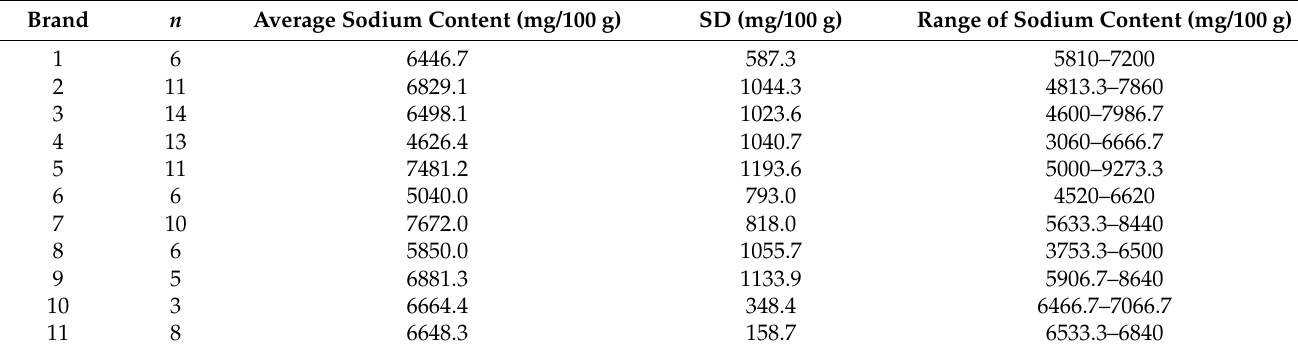
Table 3. The sodium content in 11 different brands of soy sauce.